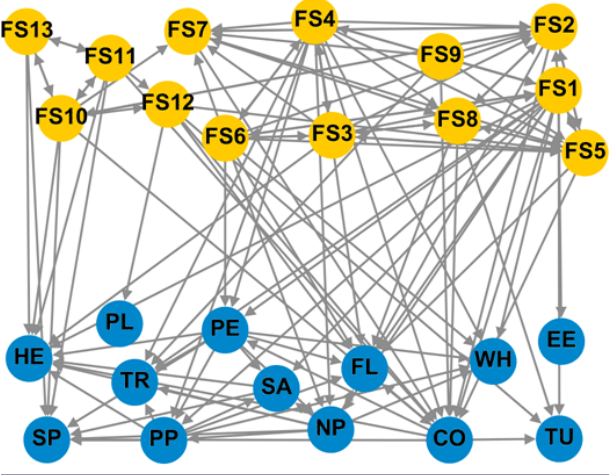
Fig. 1 . The social-ecological network of the Baltic Sea Swedish fishers demonstrates the complexity of fisheries interactions. (A) Social network, in which nodes are fishing strategies and links represent switching; (B) intermediate social-ecological network, in which nodes are fishing strategies and fishes, and links represent fishing; (C) ecological network, in which nodes are the main target fish species of Swedish fishing strategies, and links are predator-prey relationships. FS: fishing